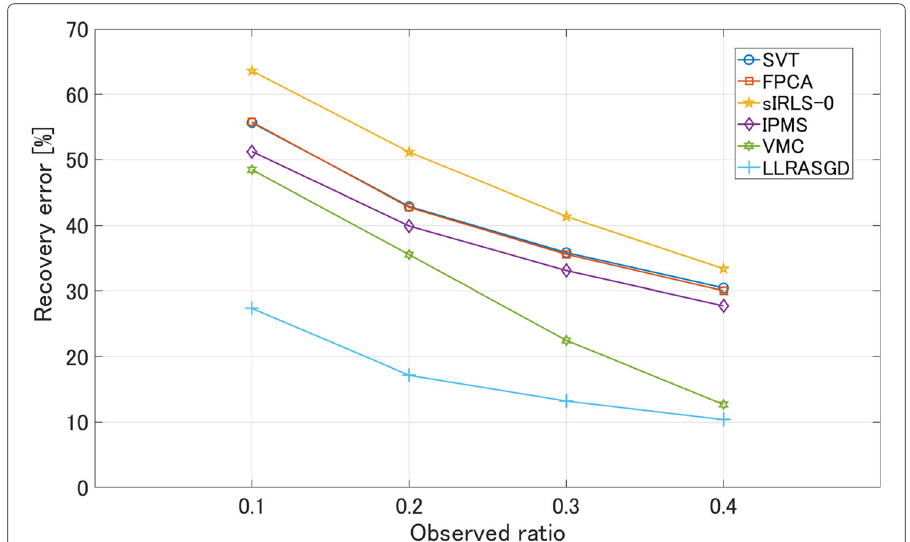
Fig. 5 Average RE for CMU motion capture data